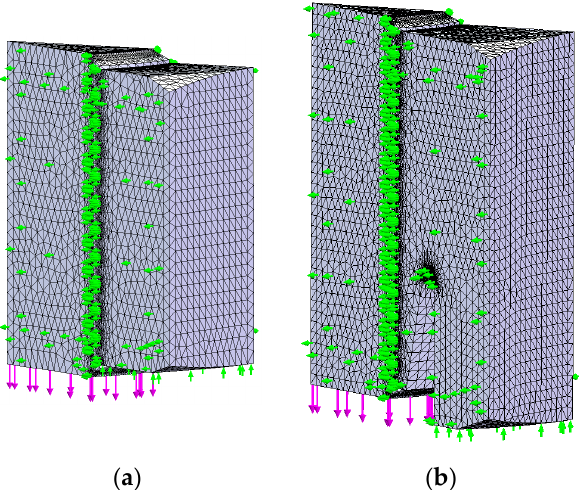
Figure 6. 1/12 of the overall model: ( a ) normalised nut; ( b ) designed nut.